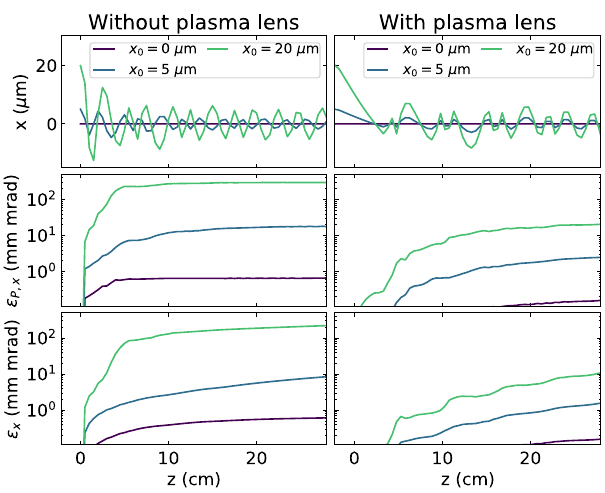
FIG. 10. Beam properties along propagation without a plasma lens (left) and with a plasma lens (right) from W arp simulations. Subplots show, from top to bottom, the transverse position, projected emittance, and sliced emittance. This image shows numerical results only; the model is not applied here. Colors stand for various initial beam transverse positions. Simulation conditions are given in Table I, where the plasma starts at z ¼ 2 cm. The plasma lens has an eighth-order super-Gaussian ¼ 2 mm, length L ¼ longitudinal profile with center z lens lens